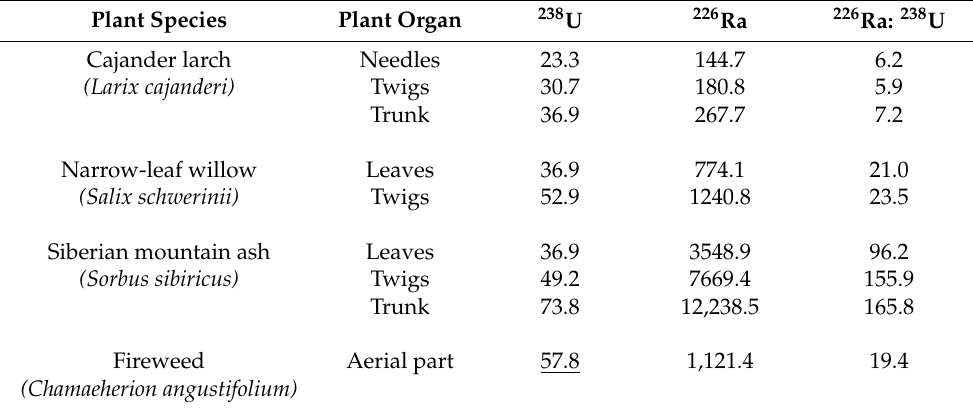
Table 8. Content of 238 U and 226 Ra in the ash of vascular plants of technogenic landscapes of Southern Yakutia,